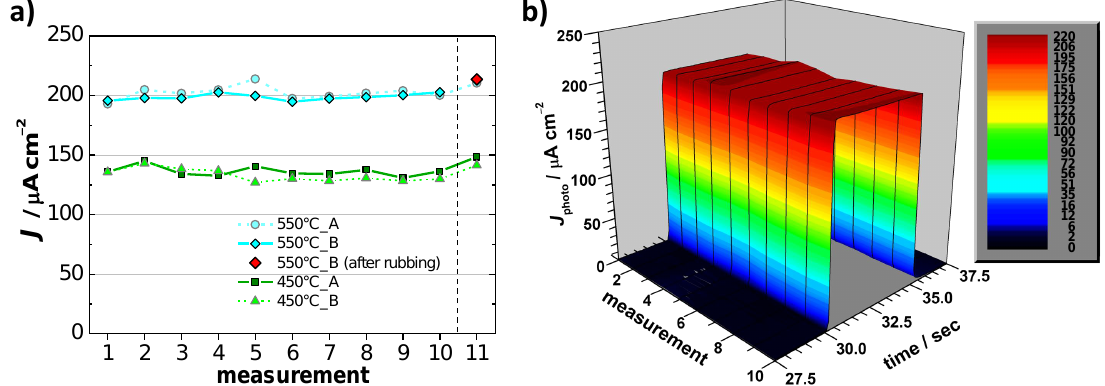
Figure 12. ( a ) Photocurrent stability tests of four 10-layered MTTFs (2 × 450 ◦ C, 2 × 550 ◦ C) recorded at ten different days (disassembling, cleaning, drying, assembling between each measurement). Photocurrent densities were derived from chronoamperometric experiments and taken after 32.5 s (right in the middle of an illumination